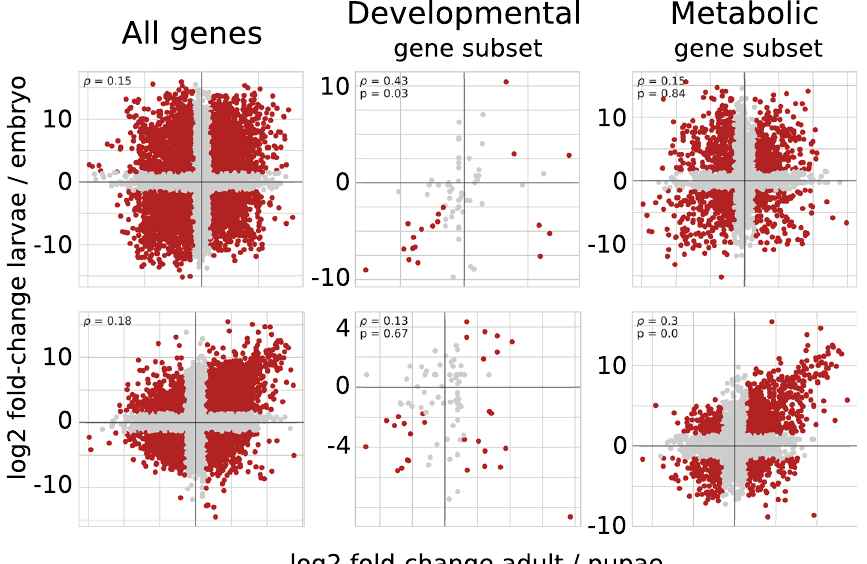
Figure 4. Changes in transcriptome profiles during the transition from the pupal to the imago stages compared to the transition from the embryonic to the larval stages for O. furnacalis (top) and T. castaneum (bottom). Each dot represents one gene, with the fold-difference between the embryo and larva expression in the y-axis and the fold-difference between the pupa and imago in the x-axis (log scales). Genes in the upper right corner of each plot have lower expression in embryo and pupa when compared to larva and imago, respectively. Three gene sets are considered: all genes (left), development-associated genes (middle) and metabolism-associated genes (right). Genes with significant LCF (greater than 1.5) are shown in